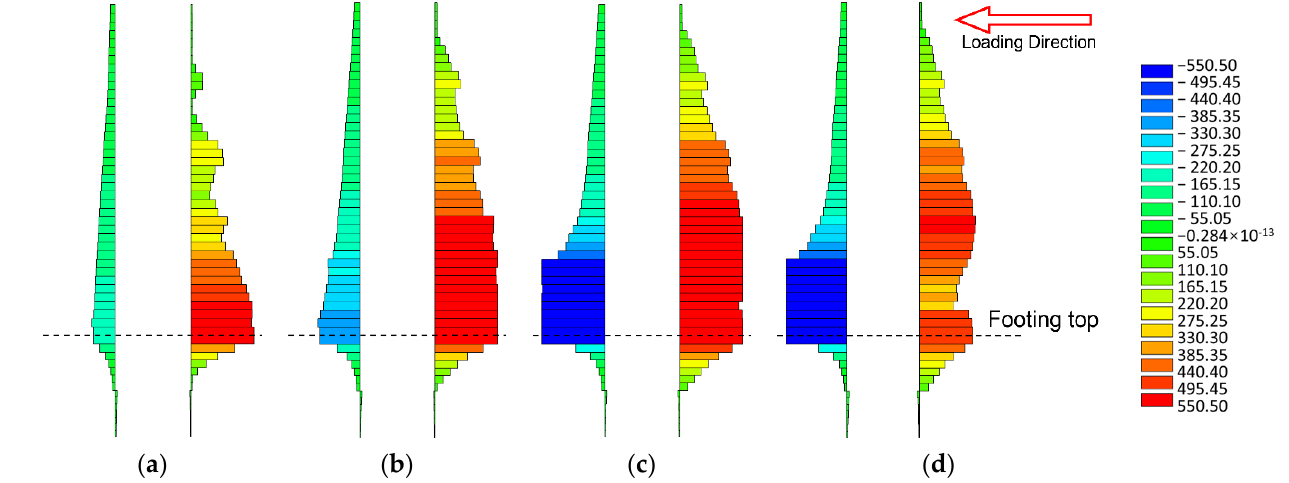
Figure 7. PMR’s outmost rebar stress diagrams at the displacement of (unit: MPa): ( a ) 20 mm; ( b ) 40 mm; ( c ) 90 mm; ( d ) 120 mm.